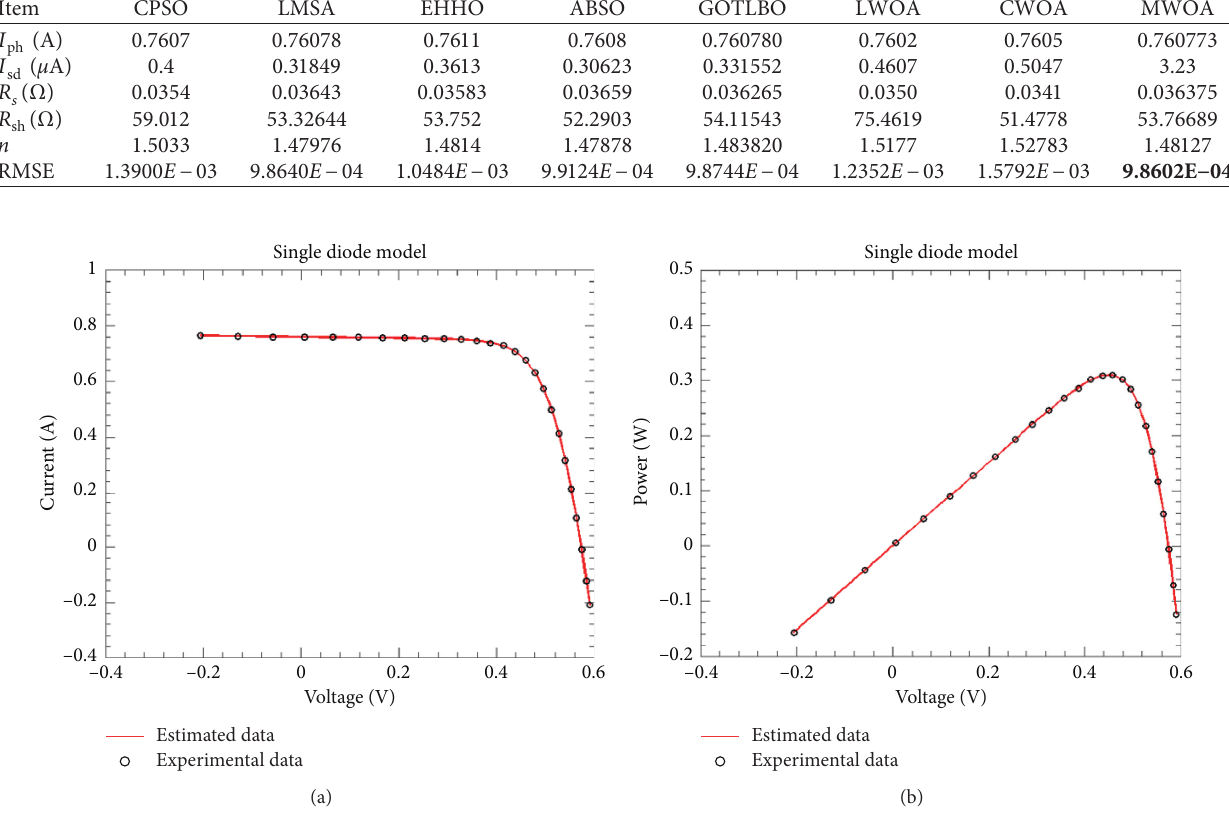
Figure 5: I-VC (a) and P-VC (b) of the best SDM obtained based on MWOA. Table 3: Simulated data and associated IAE obtained by MWAO for